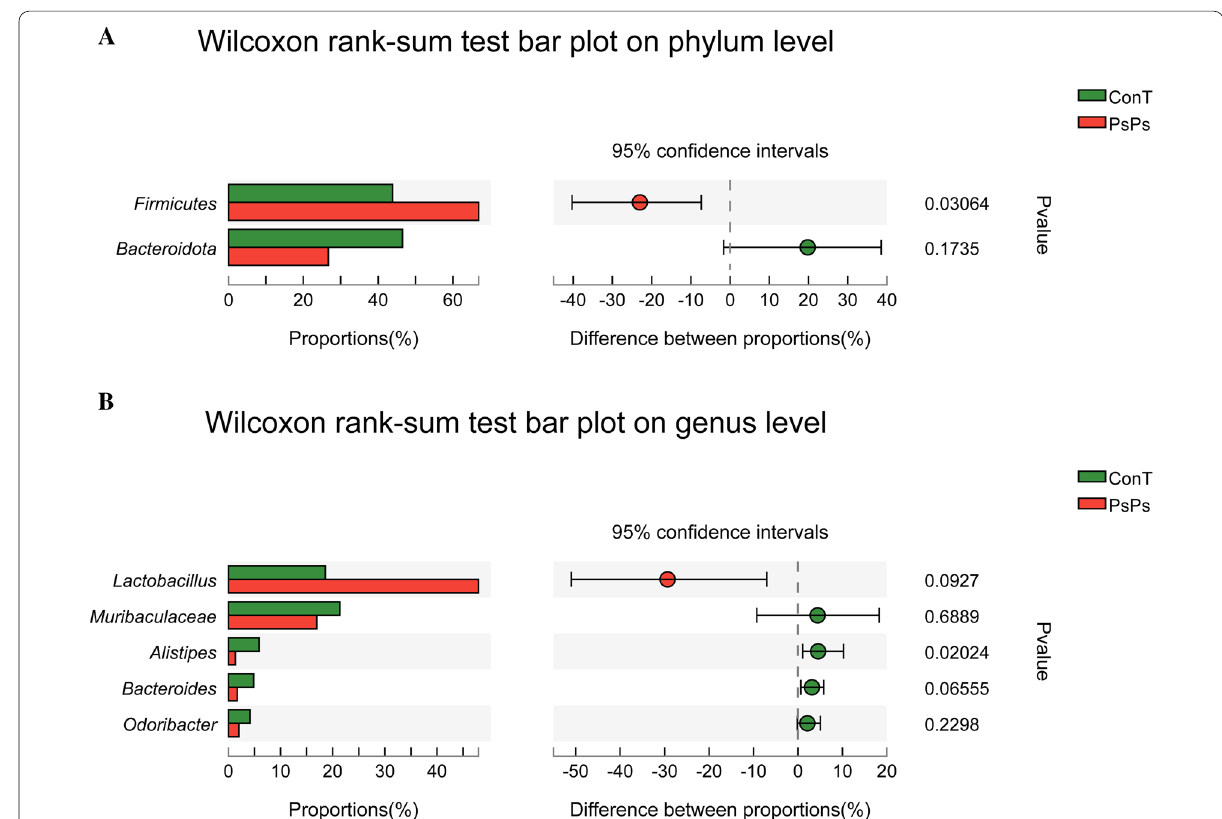
Fig. 2 Wilcoxon rank sum test of gut microbiota. A The relative abundance of gut microbiota at the phylum levels. B The relative abundance of gut microbiota at the genus